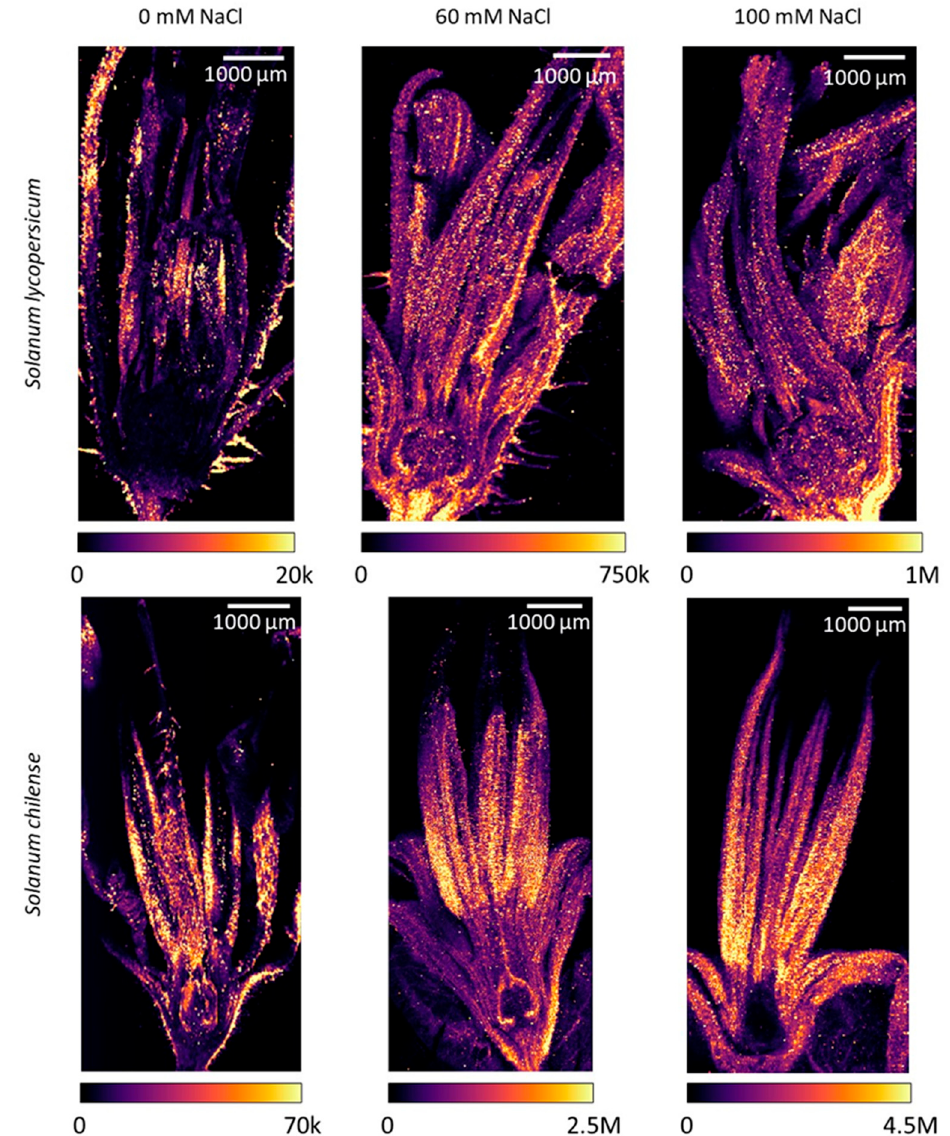
Figure 3. Sodium (Na) distribution in flowers of Solanum lycopersicum (top row) and Solanum chilense (bottom row) grown in perlite:vermiculite mixture supplied with 0, 60, and 100 mM NaCl as revealed by LA-ICP-MS (laser ablation inductively coupled plasma mass spectroscopy) and visualized using ImageJ (version 1.53a). Color legends represent the number of counts per pixel (20 × 20 µm 2 ) of each analysis.